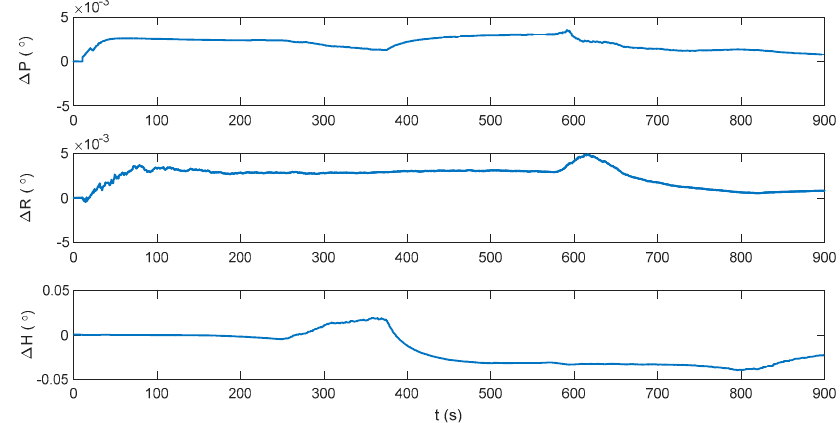
Figure 9. Attitude error of the interactive multiple model (IMM)-aided ZUPT solution.